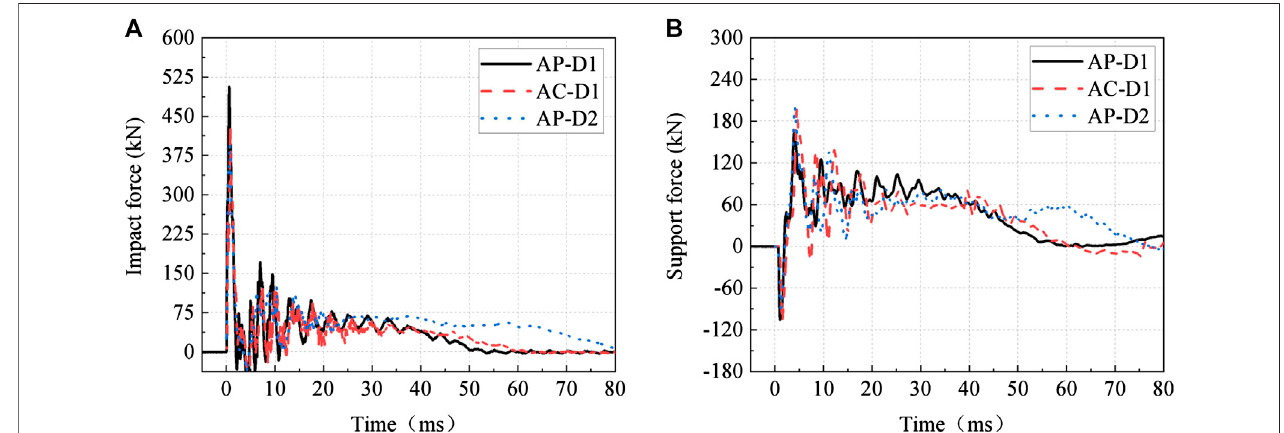
FIGURE 14 | Time delay between reaction force and impact. (A) AP-D1, (B) AC-D1, (C) AP-D2.